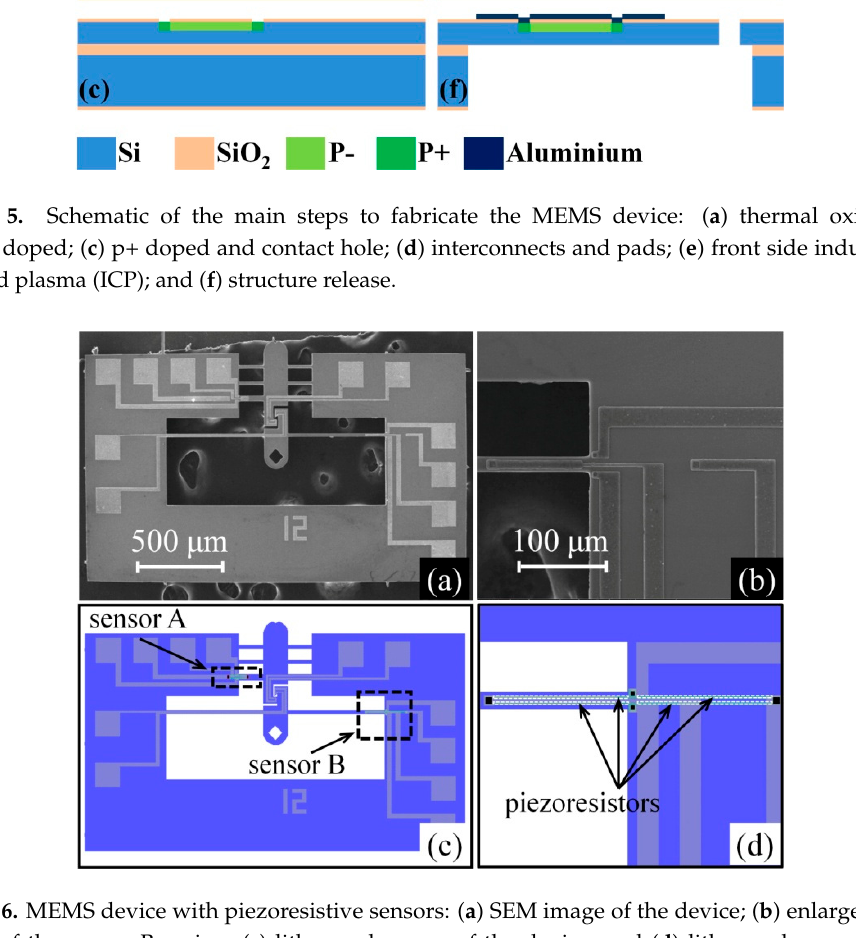
Figure 6. MEMS device with piezoresistive sensors: ( a ) SEM image of the device; ( b ) enlarged SEM image of the sensor B region; ( c ) lithography map of the device; and ( d ) lithography map of the sensor B region.